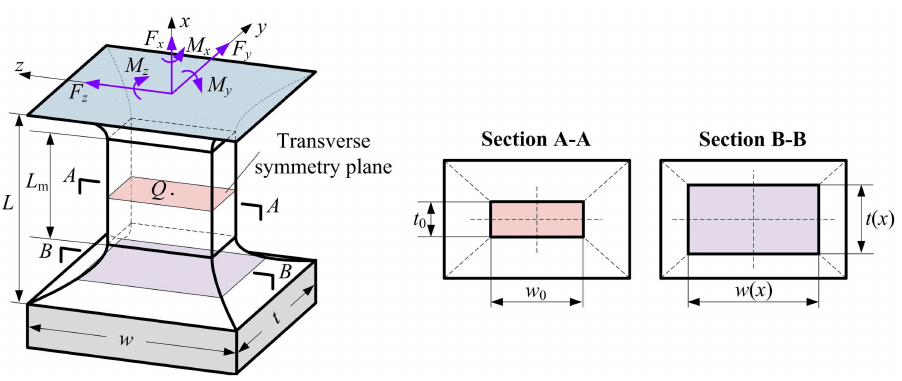
Sensors 2017 , 17 , 2154 3 of 20 elliptical-filleted and right-circular-filleted, respectively. Similarly, when L m = 0, all these two-axis corner-filleted flexure hinges above will degenerate into other six general two-axis flexure hinges.